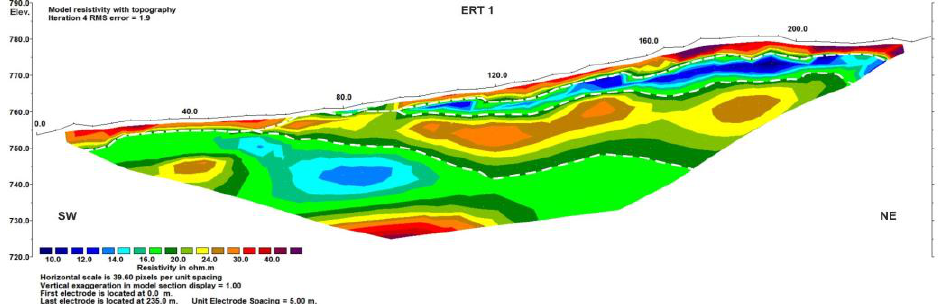
Figure 10. Electrical resistivity tomography (ERT 1) carried out parallel to the landslide body along the landslide foot. Dashed white lines outline possible sliding surfaces. Elev.: elevation above sea level.